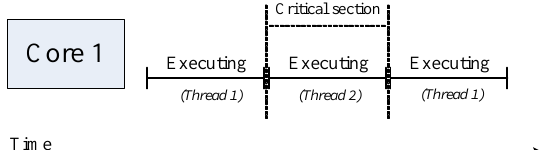
Figure 1. Critical section in the configuration of a single core.